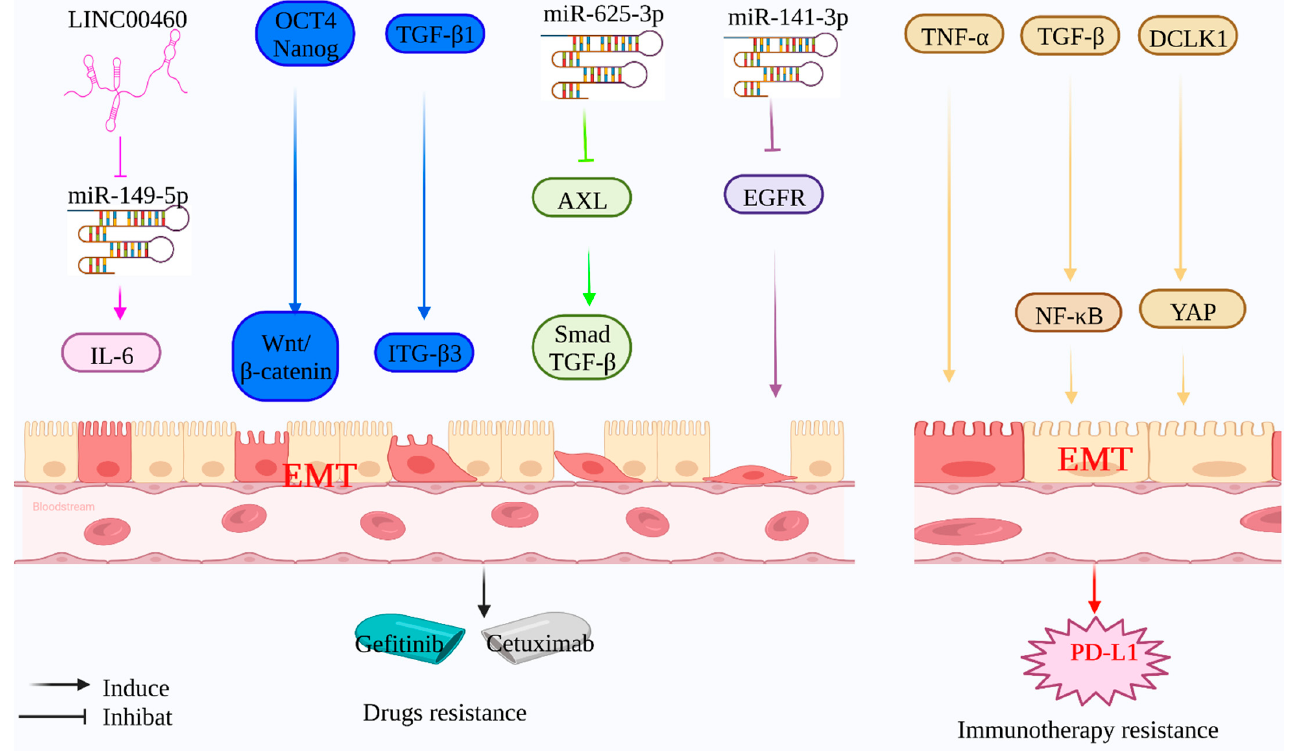
Figure 3. Mechanism of EMT-mediated targeting and immunotherapy resistance: Tumor-associated genes can induce EMT-mediated tumor cell targeting and immunotherapy resistance. LINC00460 can competitively inhibit the expression of Mir-149-5p and induce EMT by regulating expression of IL-6, thus mediating gefitinib resistance. Mir-625-3p inhibited the expression of target gene AXL and activated the TGF- β /Smad signaling pathway to induce EMT. Mir-141-3p can inhibit the expression of target gene EGFR and induce EMT, thus mediating the resistance of gefitinib and cetuximab. Tumor-associated proteins (Oct4, Nanog, and TGF- β 1) can induce EMT through related signaling pathways (Wnt/ β -catenin and ITG β 3) and mediate gefitinib resistance.